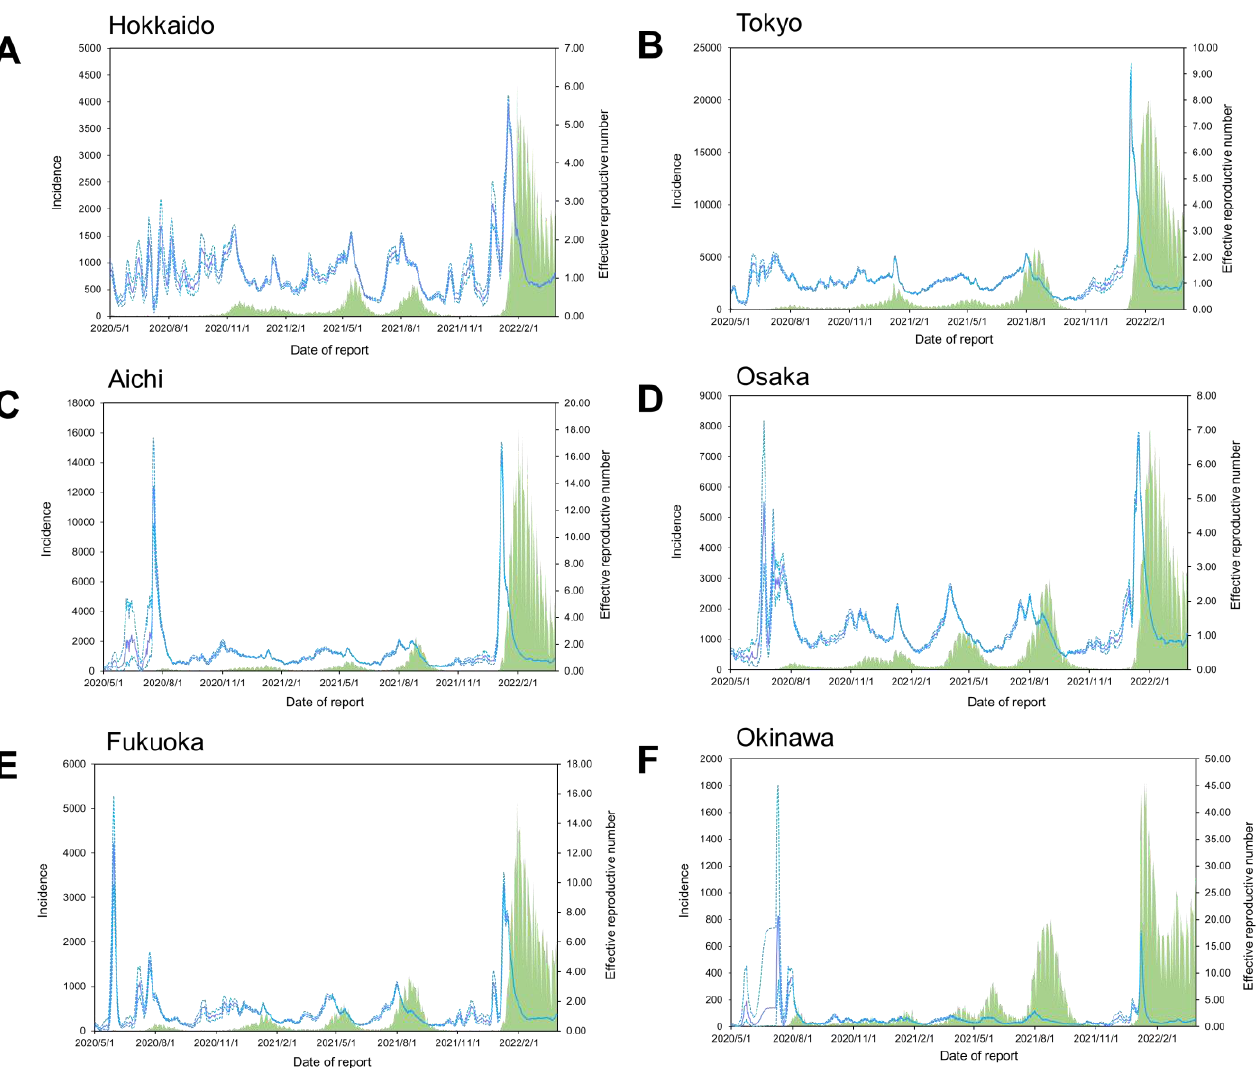
Figure 2. Epidemiologic curves for daily confirmed new COVID-19 cases, along with time-dependent effective reproductive numbers in Hokkaido, Tokyo, Aichi, Osaka, Fukuoka, and Okinawa, Japan. The number of coronavirus disease 2019 (COVID-19) cases by date of report (in green bars) from 1 May 2020 to 31 March 2022 in the six selected Japanese prefectures: ( A ) Hokkaido, ( B ) Tokyo, ( C ) Aichi, ( D ) Osaka, ( E ) Fukuoka, and ( F ) Okinawa. Purple lines and Blue dotted lines indicate the estimated time-varying effective reproductive numbers ( R t ) of severe acute respiratory syndrome coronavirus 2 (SARS-CoV-2) and the 95% confidence intervals (CIs), and the green bars represent daily incidence.